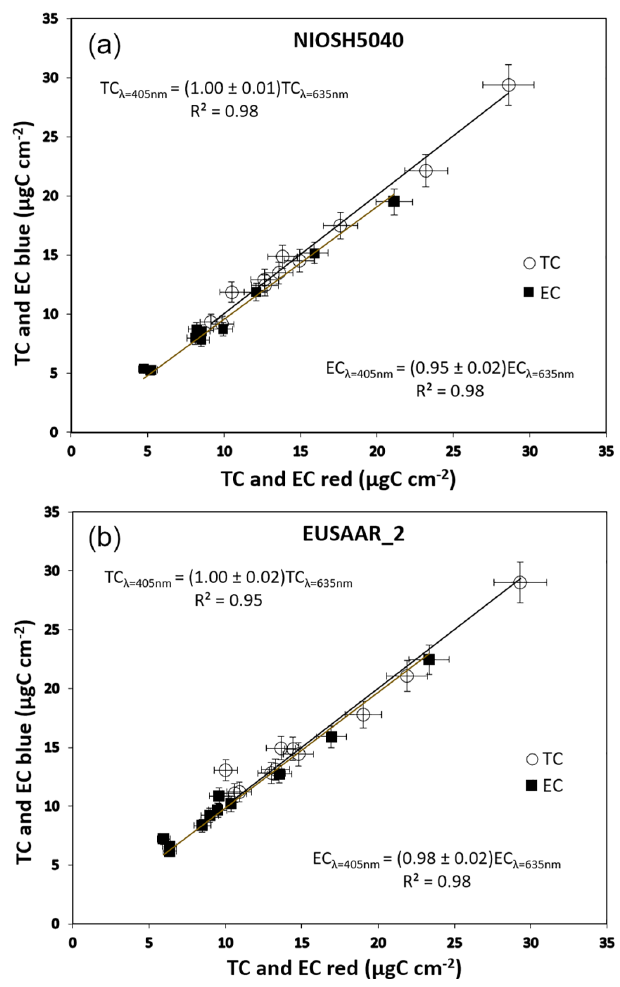
Figure 2. Quantification of TC and EC at λ = 635 (red) and λ = 405nm (blue) for the set of synthetic Aquadag samples. (a) NIOSH5040 protocol; (b) EUSAAR_2 protocol.